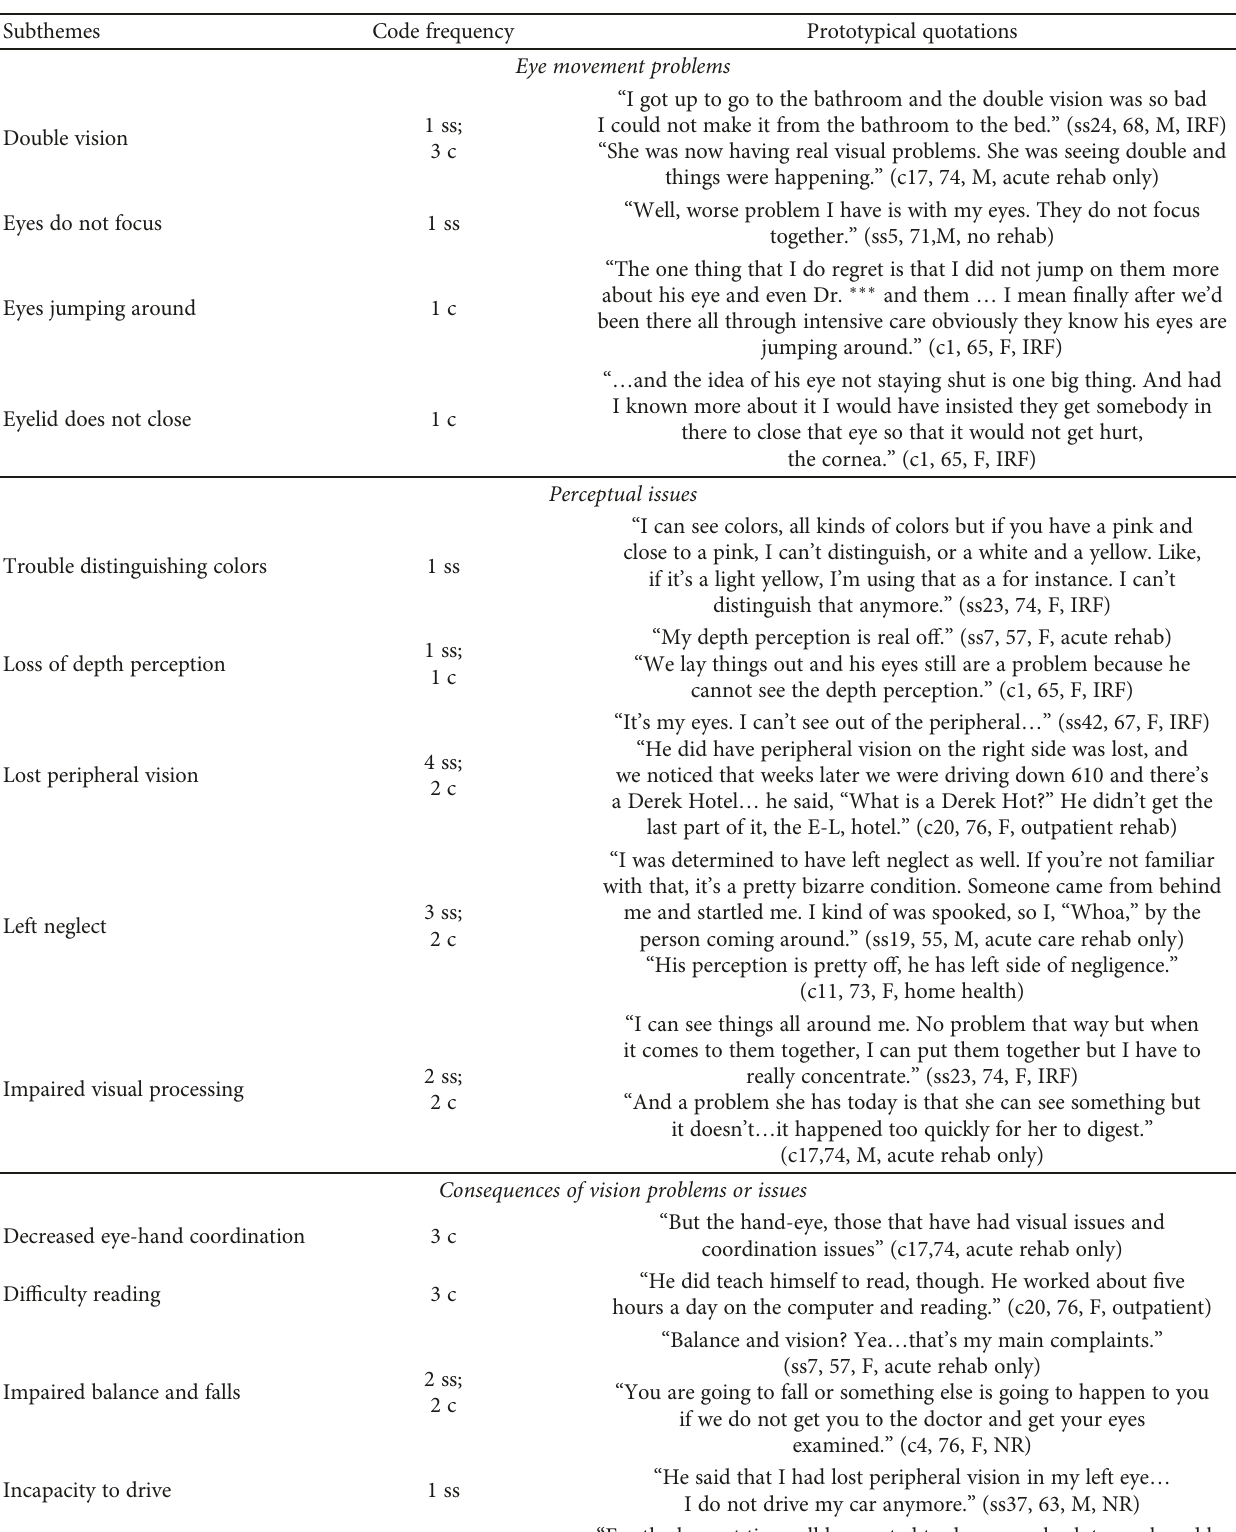
Table 1: Subthemes and codes for the theme: visual concerns and